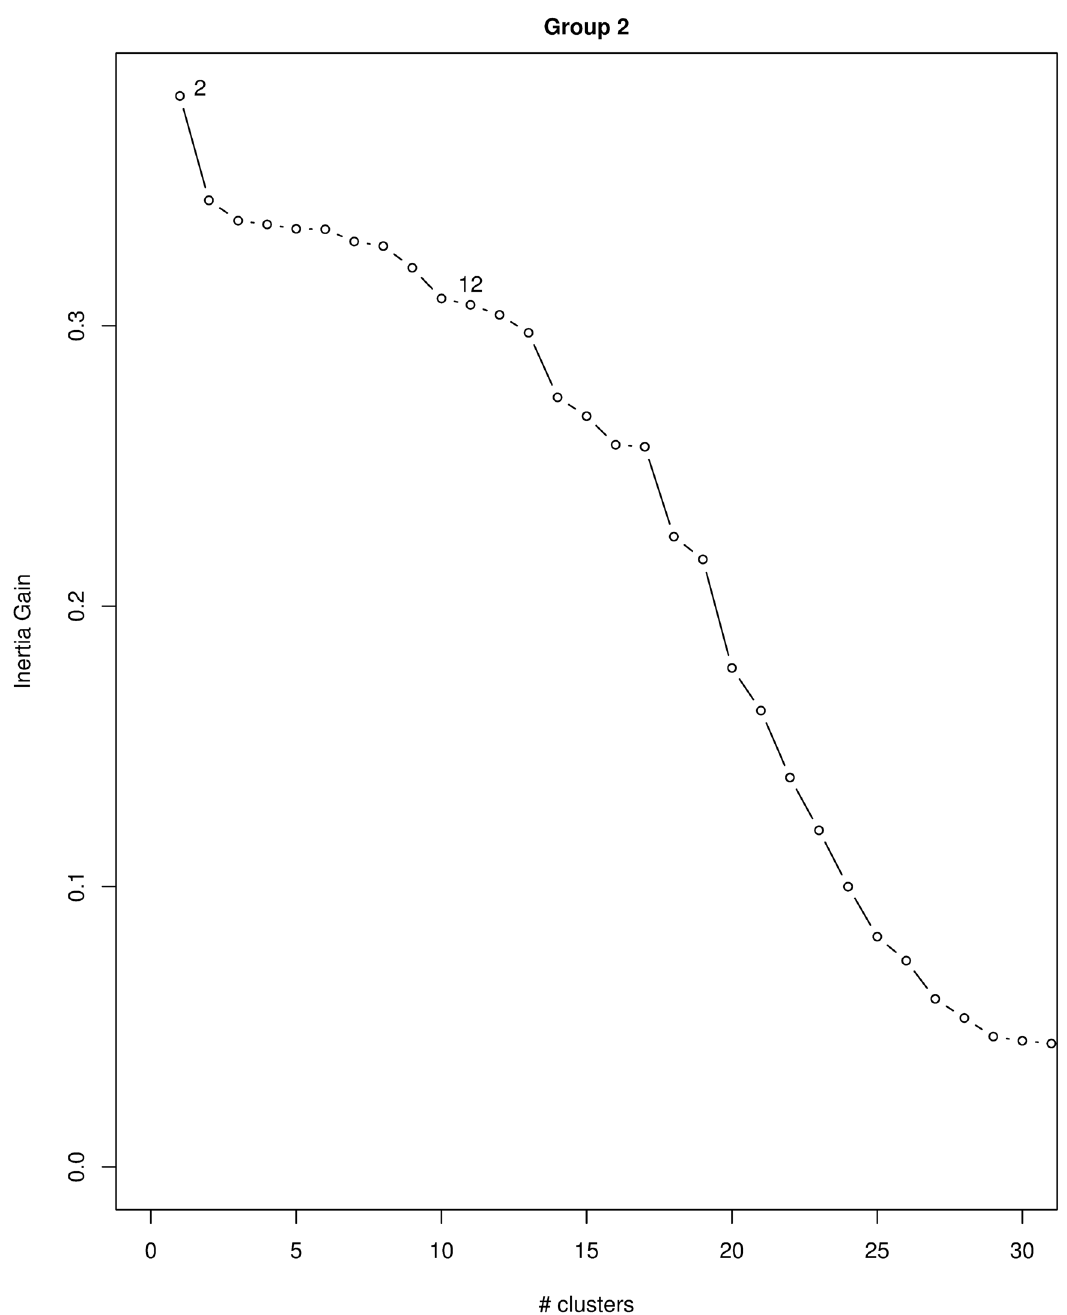
Fig 6. Plot of the between cluster inertia for group 2. Between cluster inertia (or inertia gain) smoothly decreases when the number of clusters increases and we cannot identify a clear cutoff. We chose K = 12 as a trade-off between inertia gain and interpretability of the obtained